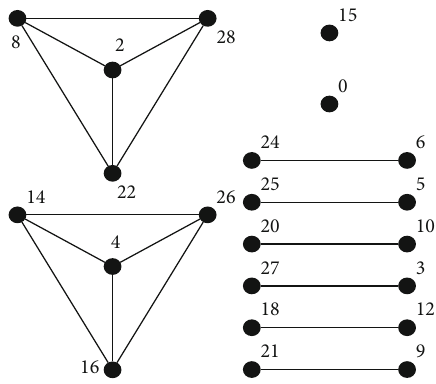
Figure 1: G ð 2, 30 Þ = 2 K